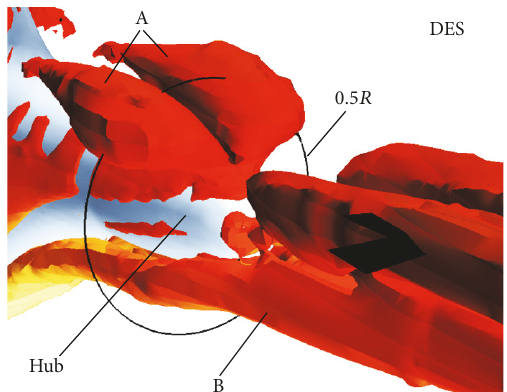
Figure 13: Simulated vortices shedding from the hull by DES, 𝑄 = 15/𝑠2 .